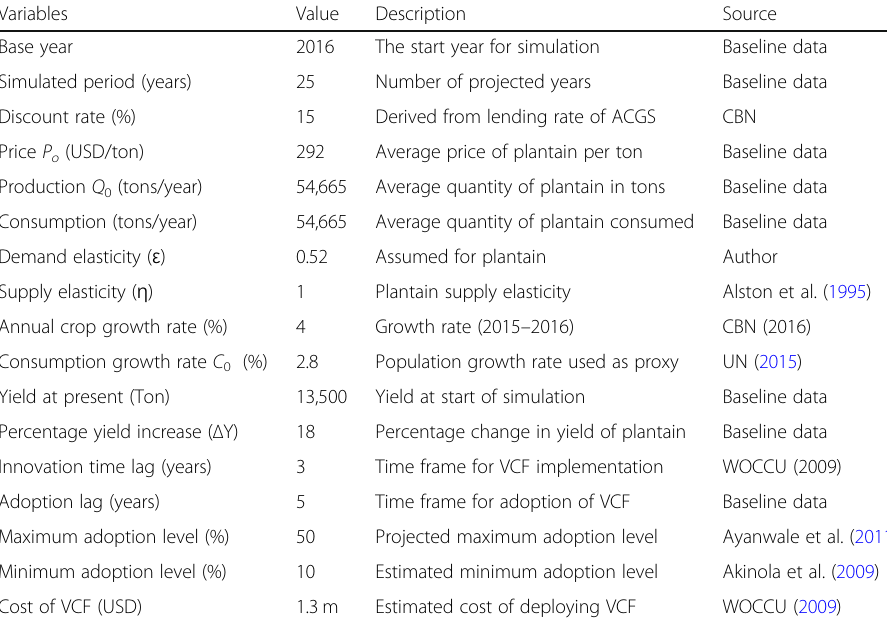
Table 2 Summary of parameters for economic surplus